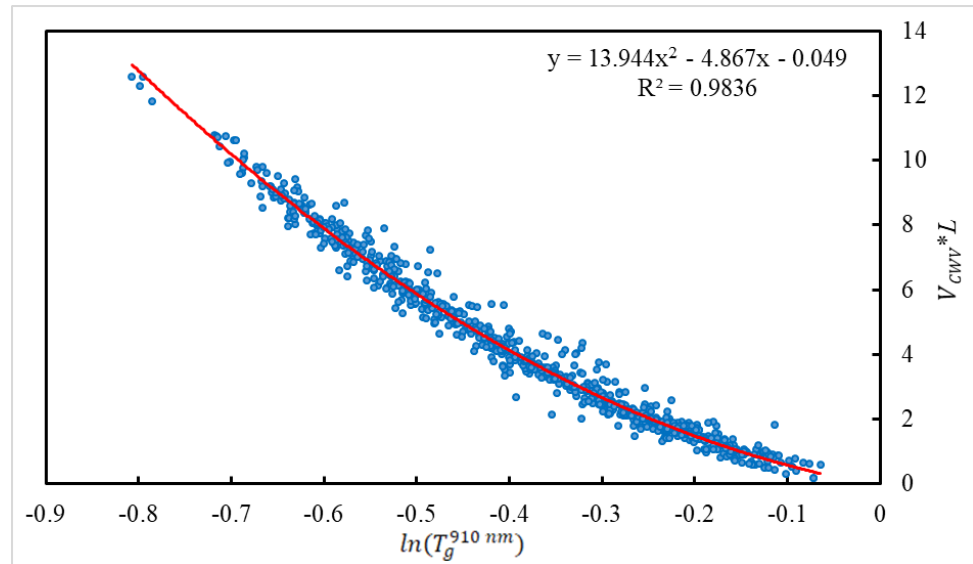
Figure 3. Scatter plot of matching results between the slanted water vapor content in the path of the sun-ground-satellite (i.e., 𝑉 𝐶𝑊𝑉 ∗ 𝐿 ) and the natural logarithm of the water vapor absorption transmittance of band 6 of PSAC (i.e., 𝑙𝑛 (𝑇 𝑔910 𝑛𝑚 ) ) in East Asia (18°-53°N, 73°-130°E). Each blue solid circle represents a matching result of AERONET data and PSAC data. The red solid line represents the fitting equation of the natural logarithm of the water vapor absorption transmittance of band 6 and the slanted water vapor content in the path of the sun-ground-satellite.